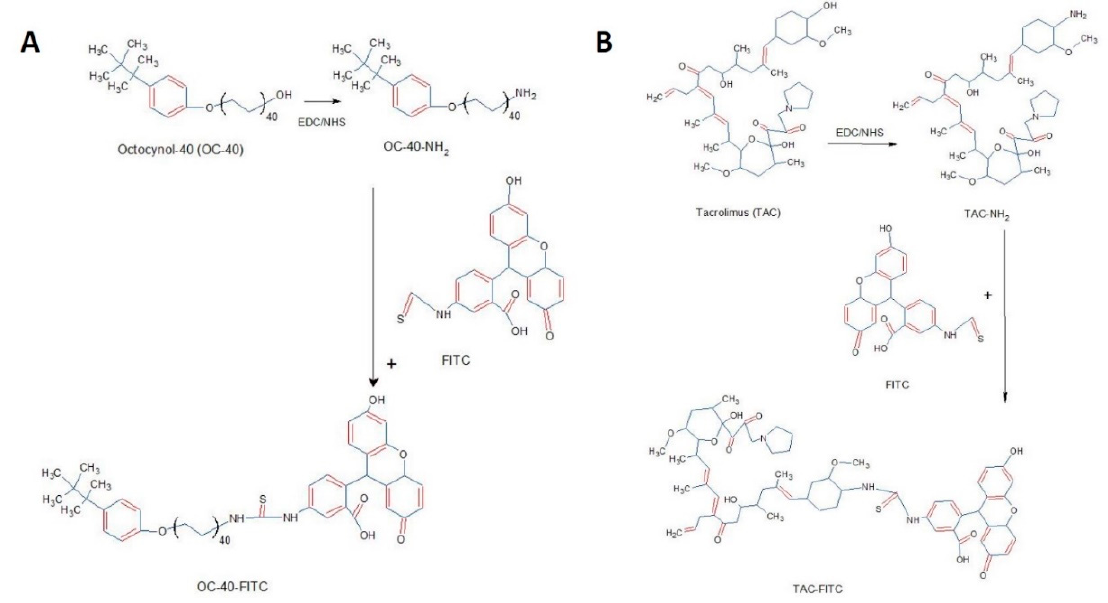
Figure 2. Fluorescein isothiocynate (FITC) conjugation reaction. ( A ) FITC conjugation to OC-40 polymer present in tacrolimus nanomicelles (TAC-NMF) formulation, vis DEC/NHS coupling reaction. ( B ) Tacrolimus (TAC) conjugation reaction to FITC via DEC/NHS coupling reaction.